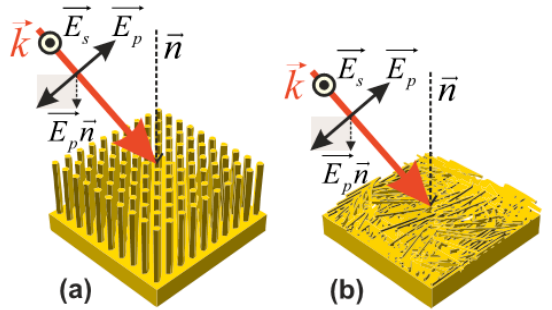
Figure 2. Schematic illustration of the laser field polarization with respect to the target geometry in the case of the ordered NW ( a ) and disordered NW ( b ) samples. E p and E s represent the electric fields of the p- and s- polarized light, respectively. n represents the vector normal to the target, and k the wave vector of the incident beam. Reference measurements were carried out with flat, 0.5 µm thick polished ZnO bulk substrates (CrysTec GmbH), which were oriented along the [0001] direction.